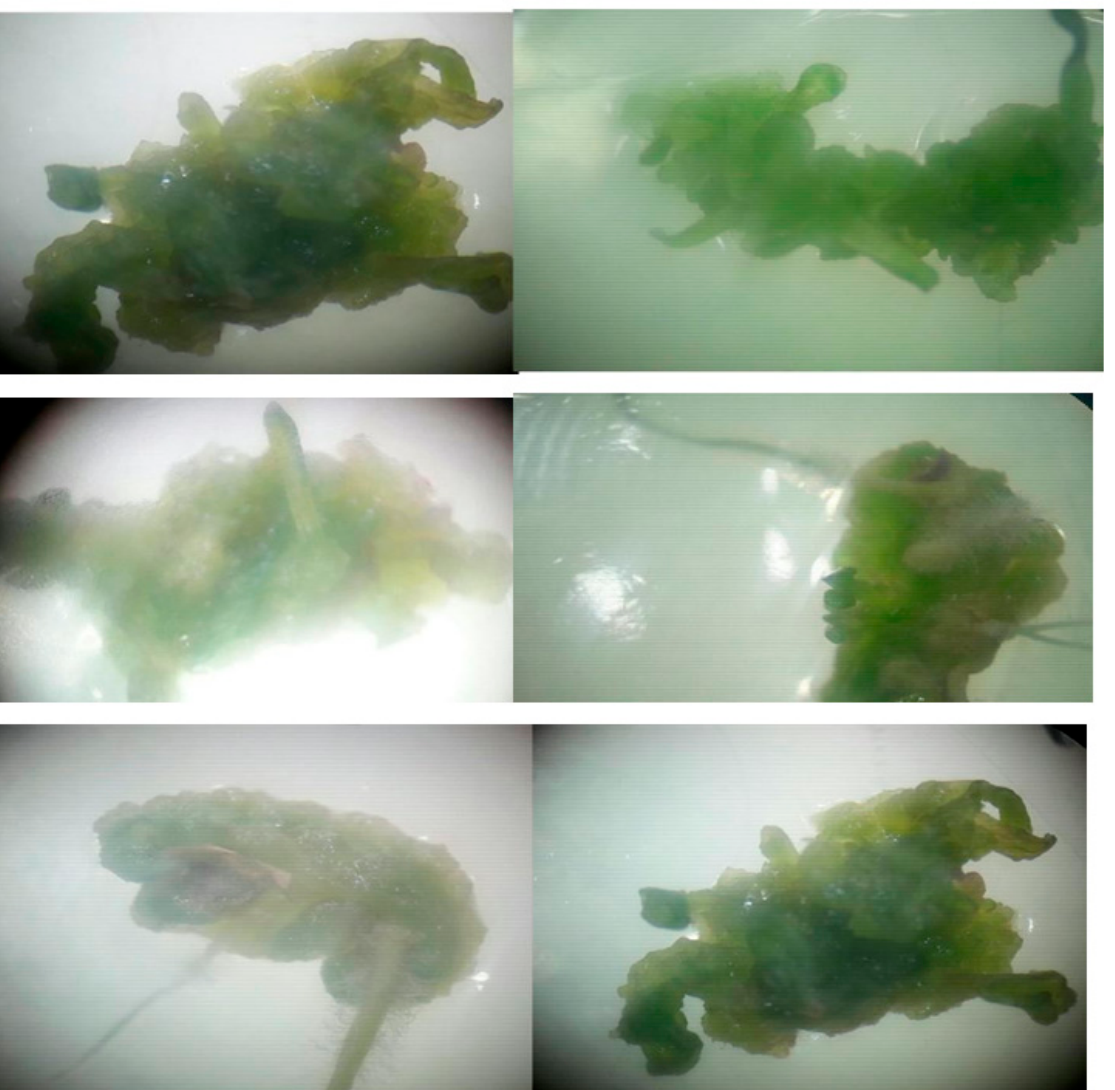
Table 2. Phenolic compositions of Cichorium intybus